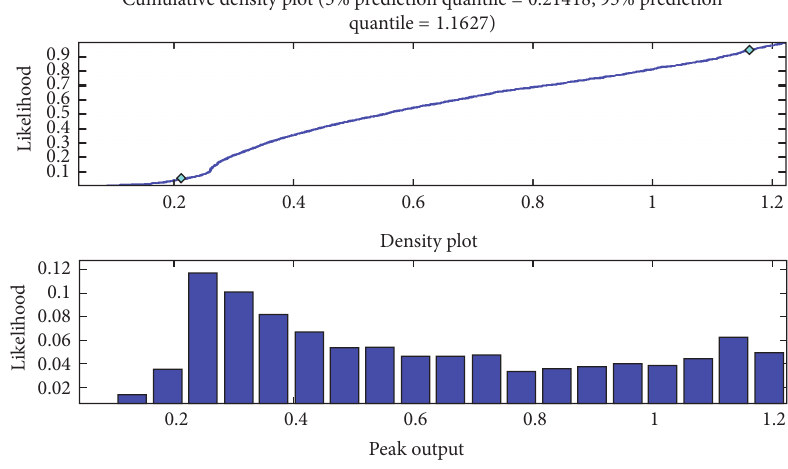
Figure 5: GLUE variable uncertainty plot. Table 3: Objective function values obtained by different algorithms only for the desorption